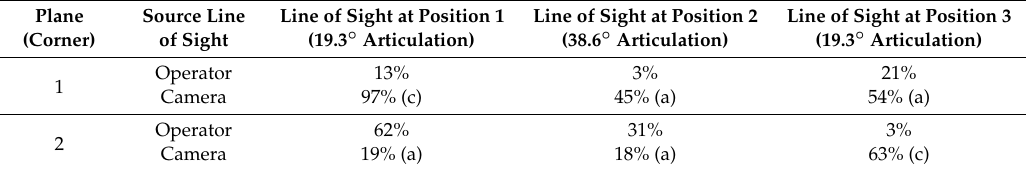
Table 2. LOS for operator and camera during articulated movement at three points. Camera responsible for best view listed in parentheses.